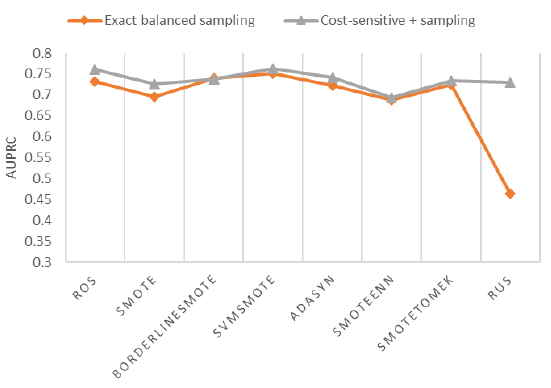
Figure 10. AUPRC of exact-balance sampling and sampling + cost-sensitive.